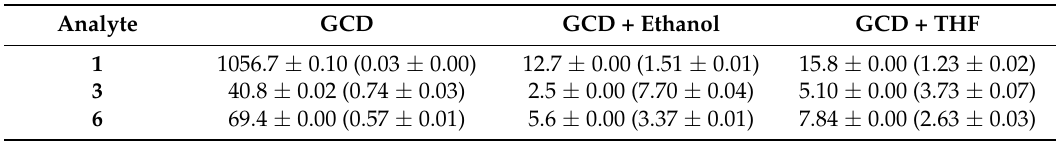
Table 5. Results of select energy-transfer experiments in the absence and presence of ethanol and THF co-solvents with compound 7 (control ratios are shown in parentheses) a .